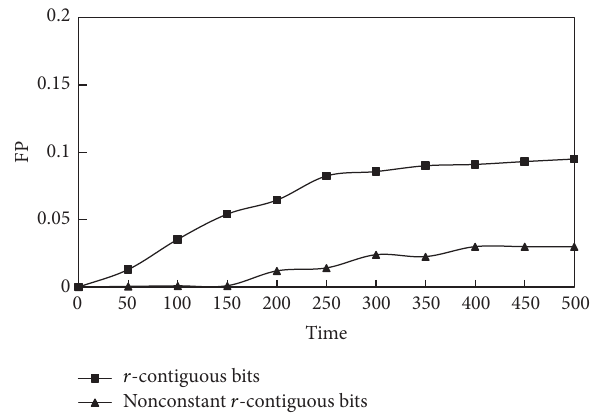
Figure 2: The self-false detection rate of two matching